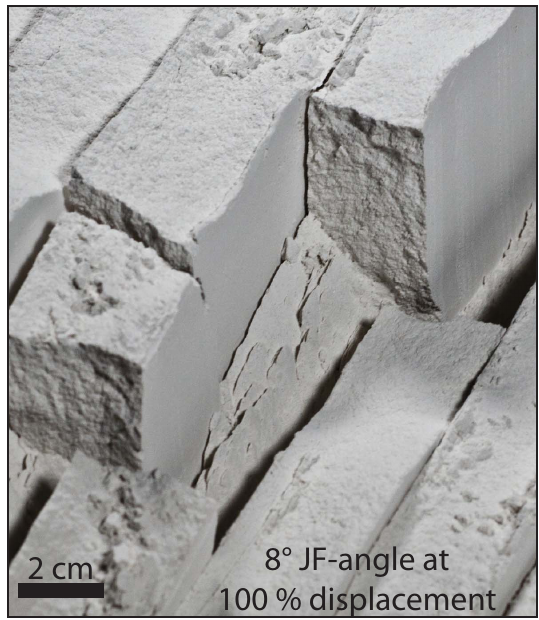
Figure 8. Wedge shape at a fault